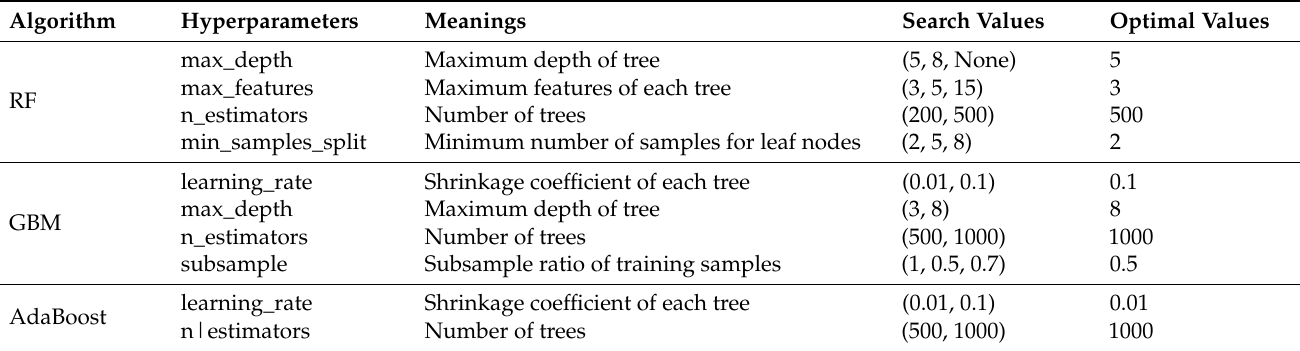
Table 3. Results of hyperparameter